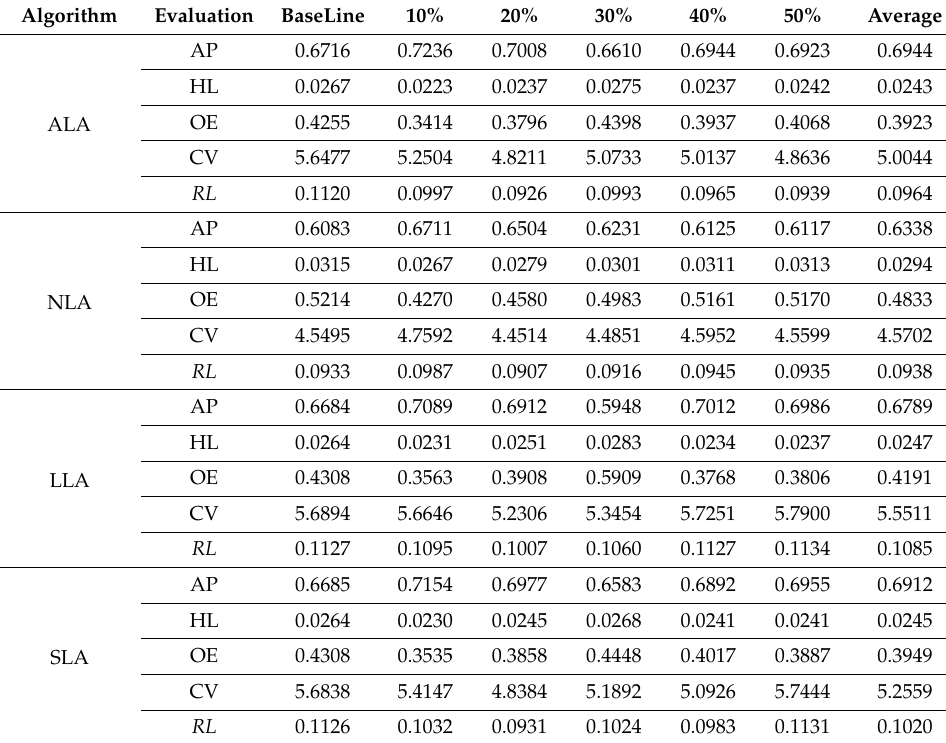
Table 8. Experimental results on Social data